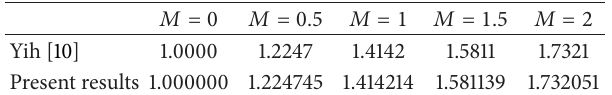
Table1:Comparisonof −𝑓 󸀠󸀠 (0) valuesforvariousvaluesof 𝑀 when 𝑁 = Gr = 𝑆 = 0 . 𝑀 = 0 𝑀 = 0.5